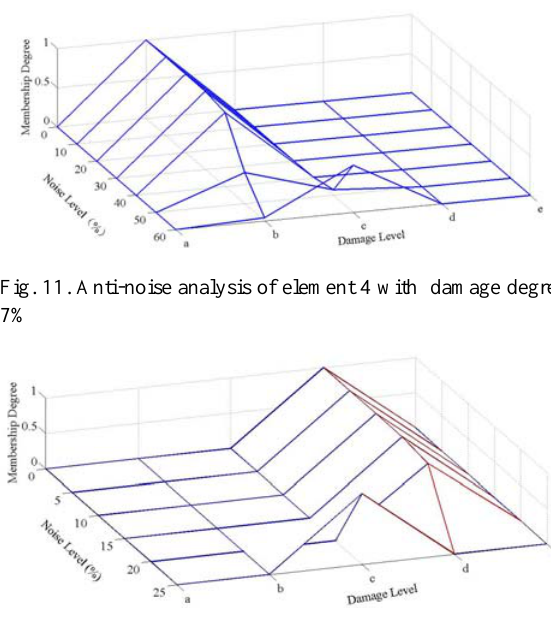
Fig. 12. Anti-noise analysis of element 4 with damage